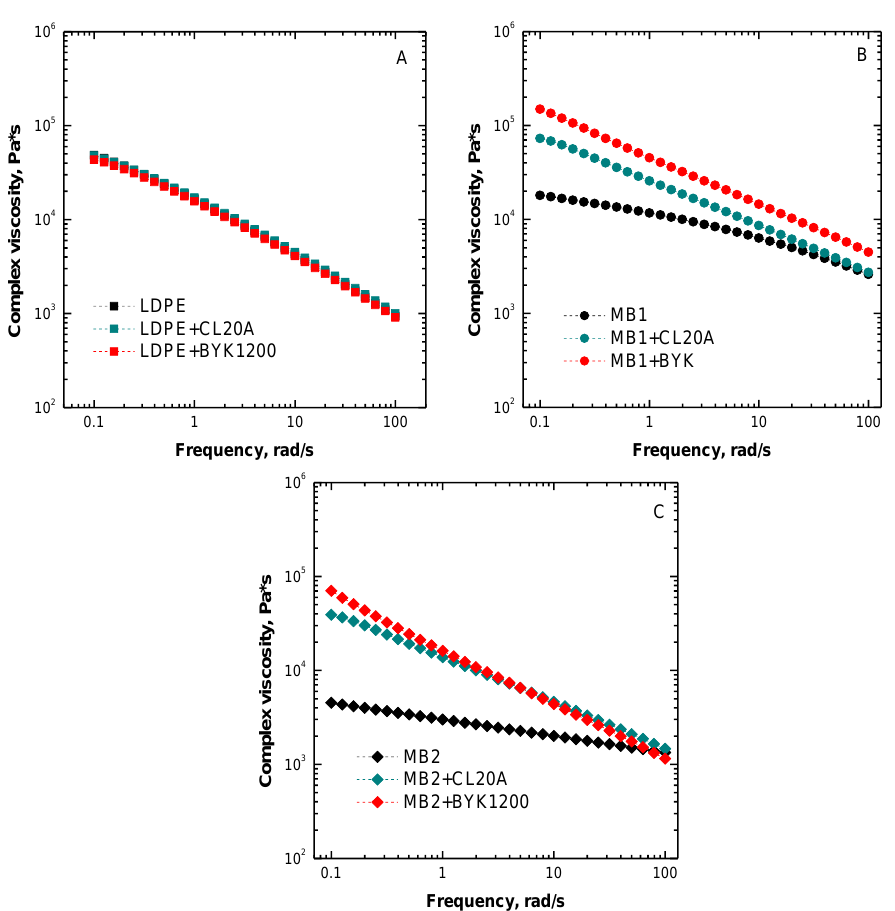
Figure 2. Complex viscosity curves as a function of frequency for ( A ) LDPE-, ( B ) MB1-, and ( C ) MB2-based nanocomposites. The complex viscosity trends for the unfilled matrices are also re- ported.